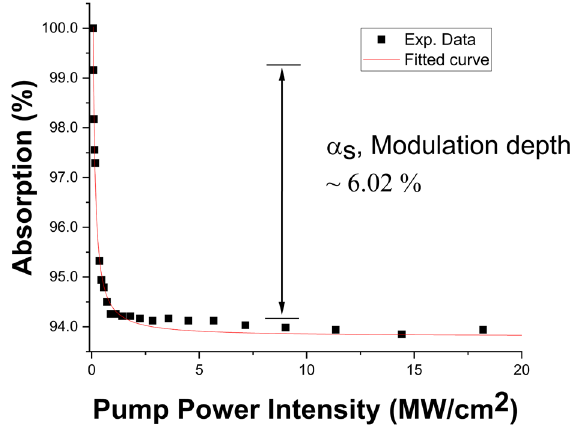
Figure 5. The nonlinear absorption measurement of the Ta 2 AlC-based tapered fiber.